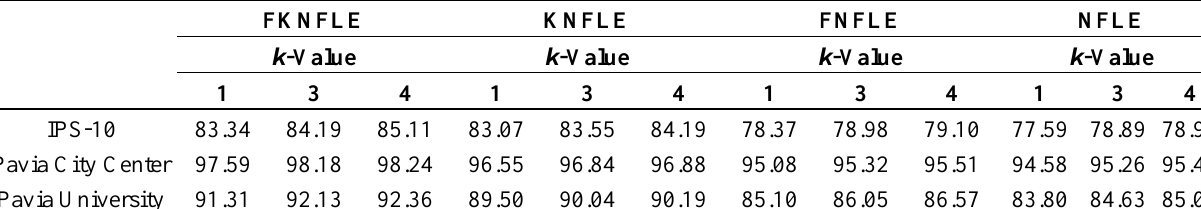
Table 7. The classification performance using various k -NN for data set IPS-10 (in